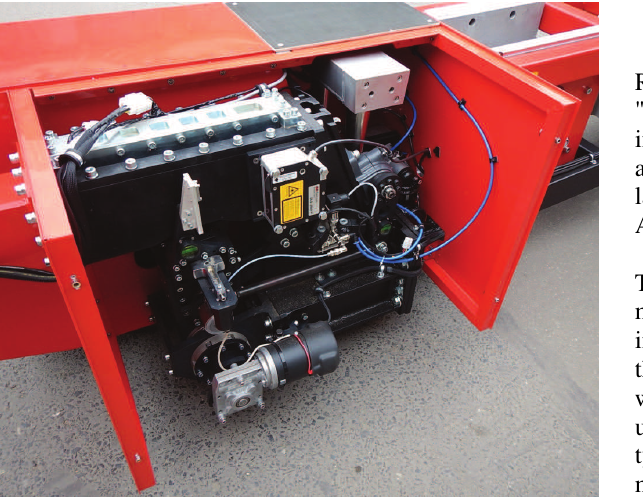
Fig. 6. Interior of the test trailer R 2 Mk.2